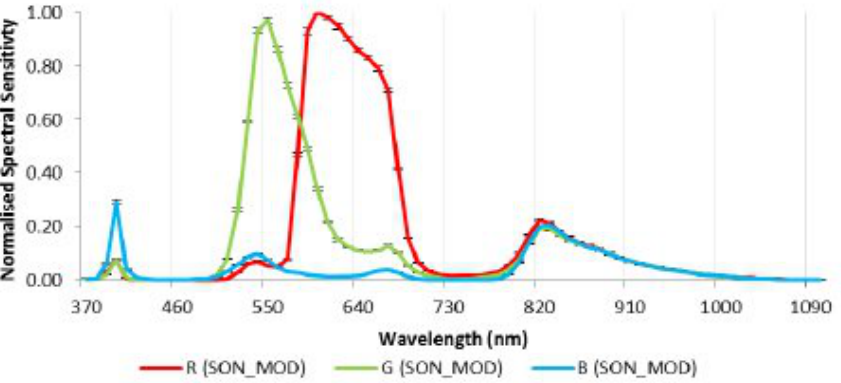
Figure 5. Spectral response for the modified Sony camera, normalised to the peak of the red channel (Source: Berra et al. [27]).